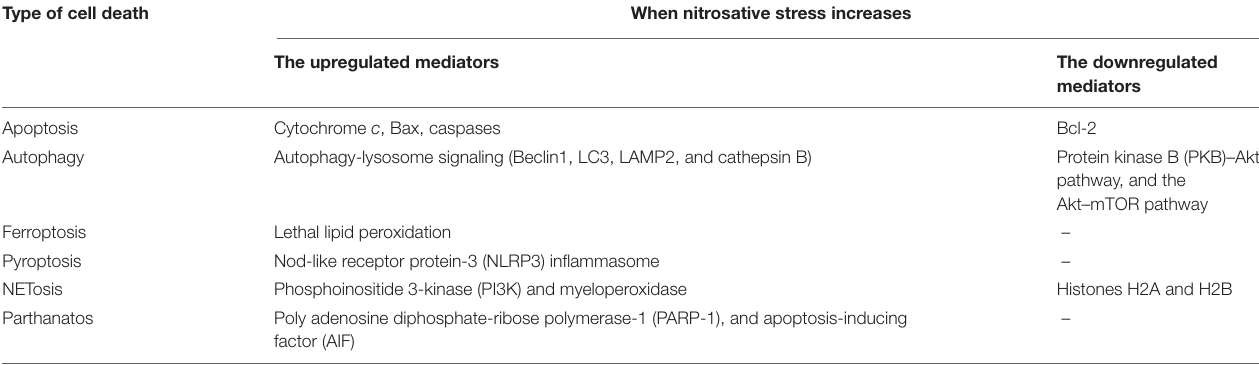
TABLE 1 | Cell death caused by nitrosative stress.